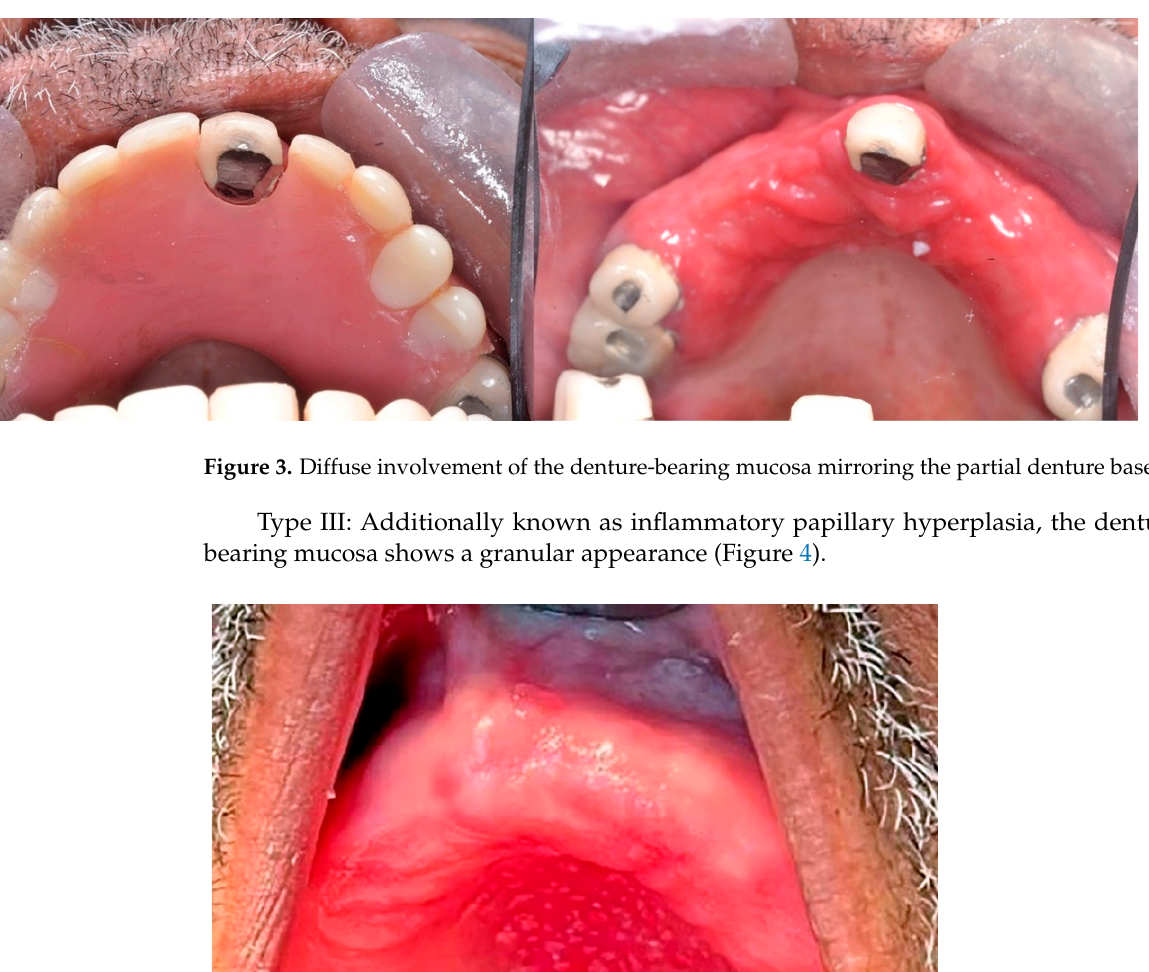
Figure 2. Diffuse involvement of the denture-bearing mucosa in a patient with an upper partial denture.